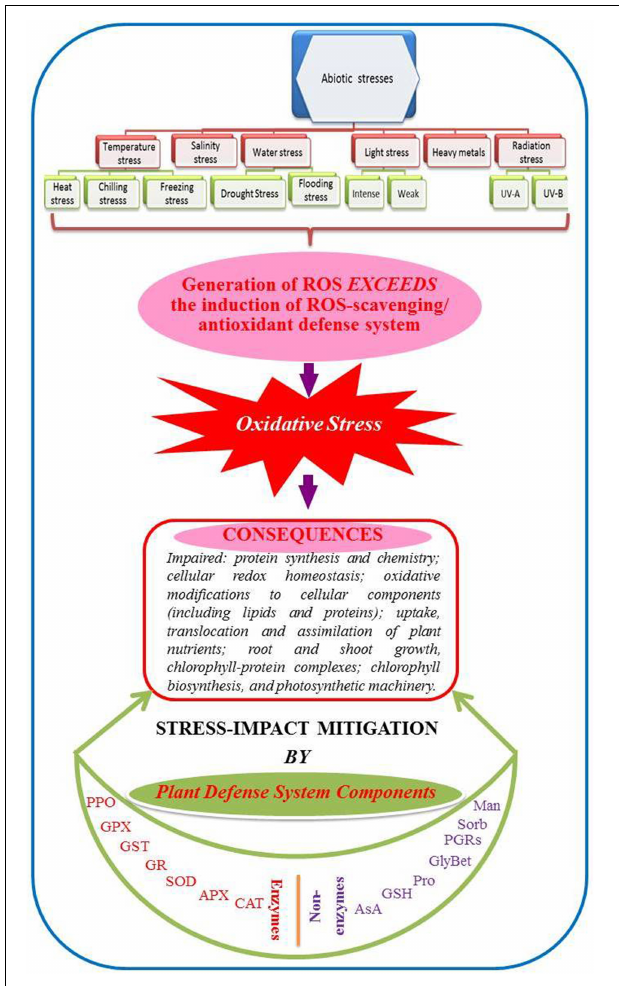
FIGURE 1 | Schematic representation of major abiotic stresses, their consequences and the components of plant antioxidant defense system. (CAT, catalase; APX, ascorbate peroxidase; GR, glutathione reductase; GPX, glutathione peroxidase; GST, glutathione sulfo-transferase; SOD, superoxide dismutase; PPO, polyphenol oxidase; AsA, reduced ascorbic acid; GSH, reduced glutathione; Pro, proline; Man, mannitol; Sorb, sorbitol; GlyBet, glycine betaine; PGRs, plant growth regulators; ROS, reactive oxygen species) (Modified after Anjum et al., 2014). FIGURE 2 | Examples of commonly used bioactive